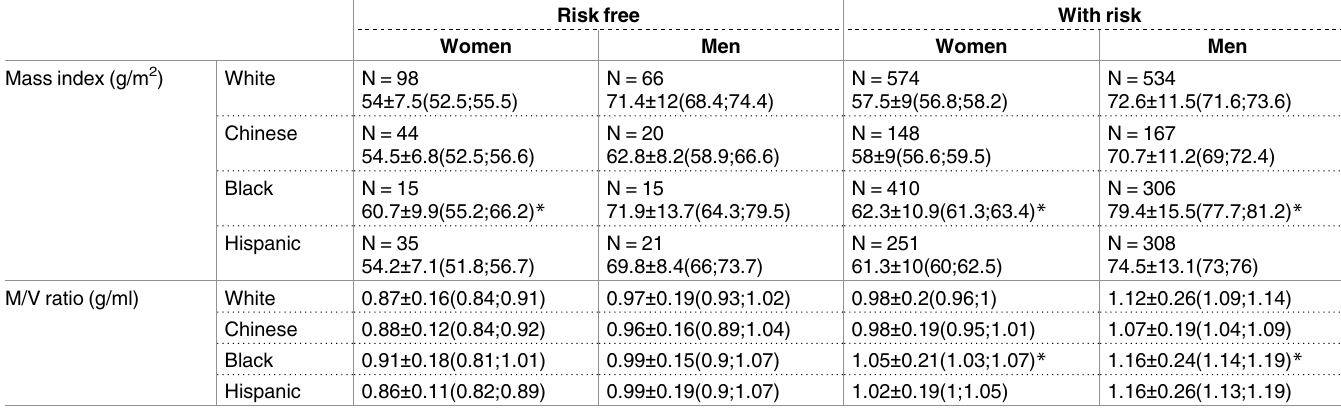
Table 2. Left-ventricular massindex by body surfacearea and mass to volume (M/V) ratio of risk-freeand with risk MESA participants stratified by gender and race. Values displayedas mean ± SD(95% confidenceinterval). * p < 0.05of the unpairedt-test betweenblack and white in the corresponding